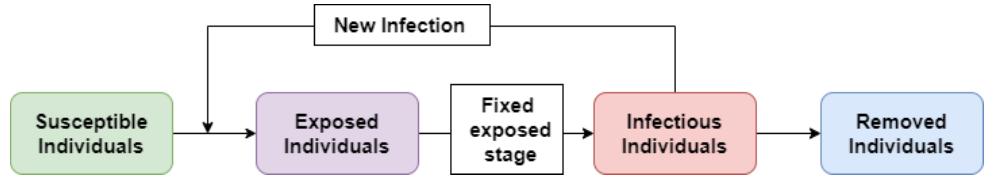
Figure 1. Compartmental diagram of interactions between susceptible individuals, exposed individ- uals, infectious individuals and removed individuals. The length of the exposed stage is considered as a constant τ